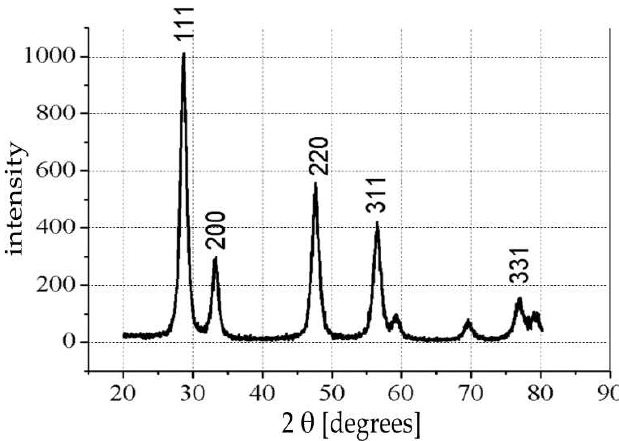
Figure 3. XRD pattern of the CeO 2 ceramic nanocontainers heat-treated at 600 °C.